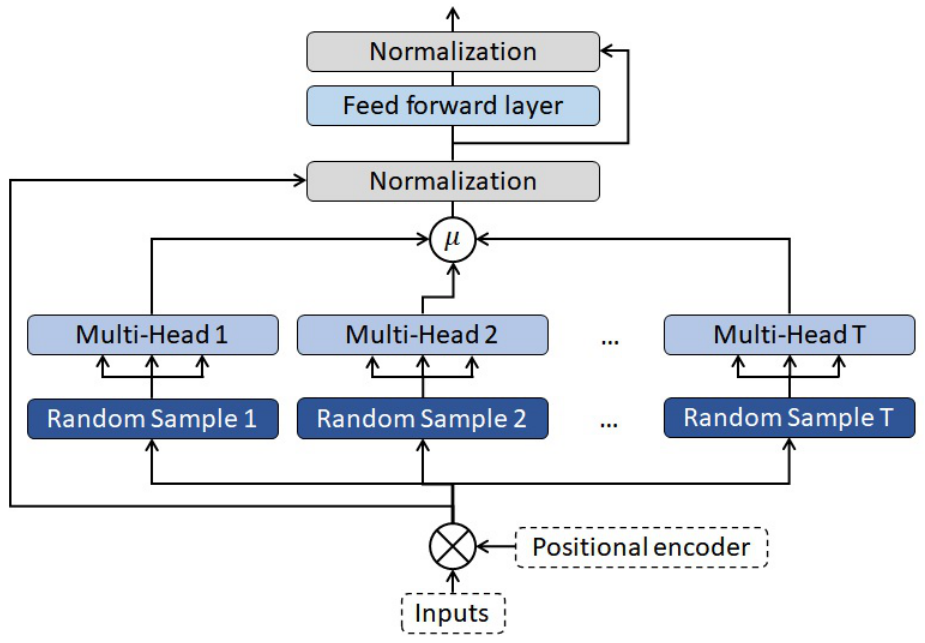
Figure 5. Multi-Transformer